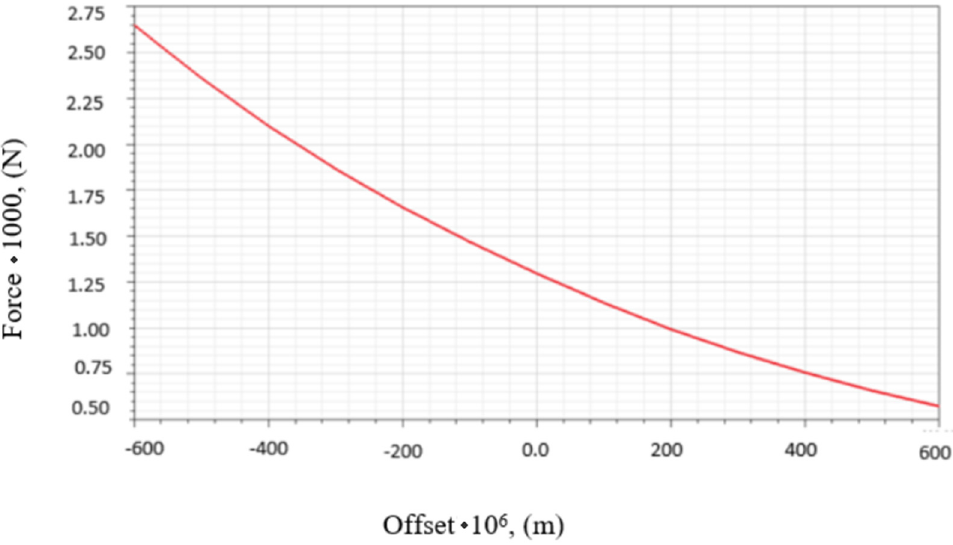
Figure 11. The dependence of the bearing capacity of a magnetic bearing on the displacement at a current of 40 A.